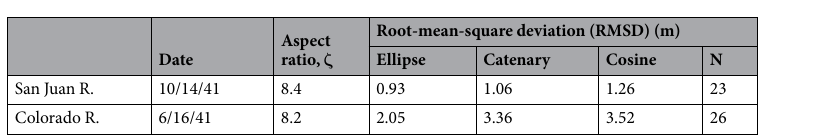
Figure 2. Comparisons of the theoretical (ellipse, catenary, cosine) and observed 3 river cross-sections during the flood periods in 1941. The datum was set at the water surface during high flows.